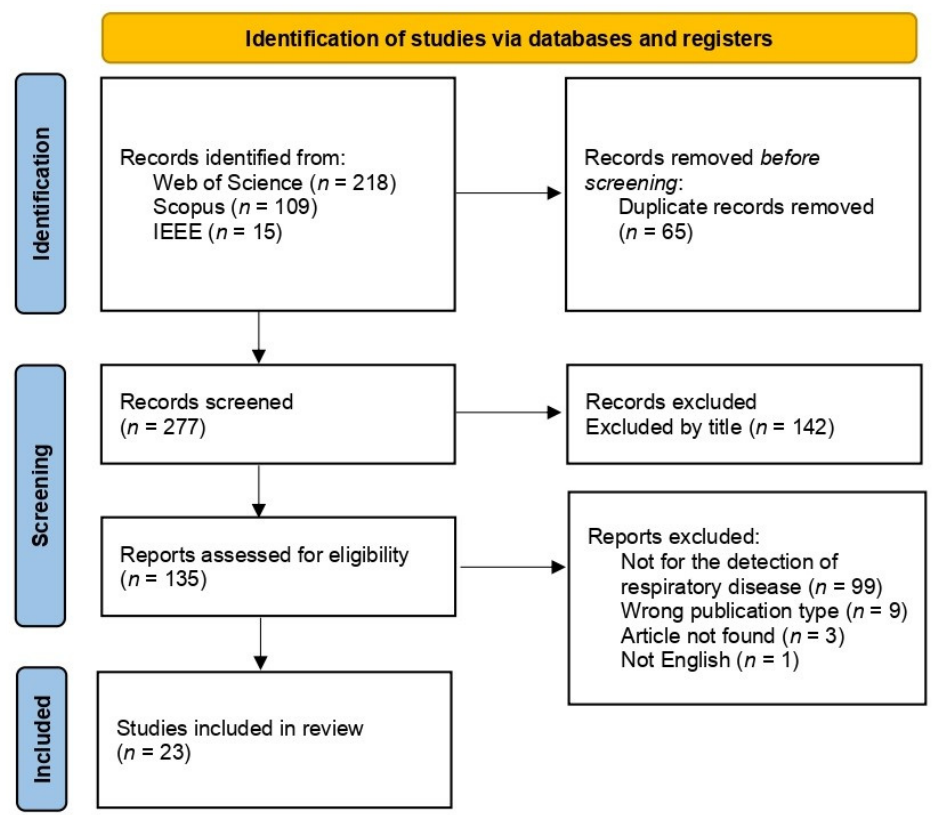
Figure 1. Modified Preferred Reporting Items for Systematic Reviews and Meta-Analyses (PRISMA) flow diagram [24] containing information of the strategy for the systematic review search and study selection. The PRISMA checklist is presented as Supplementary Table S1. Three articles were excluded because we were unable to find the full text. One article inaccurate translation.